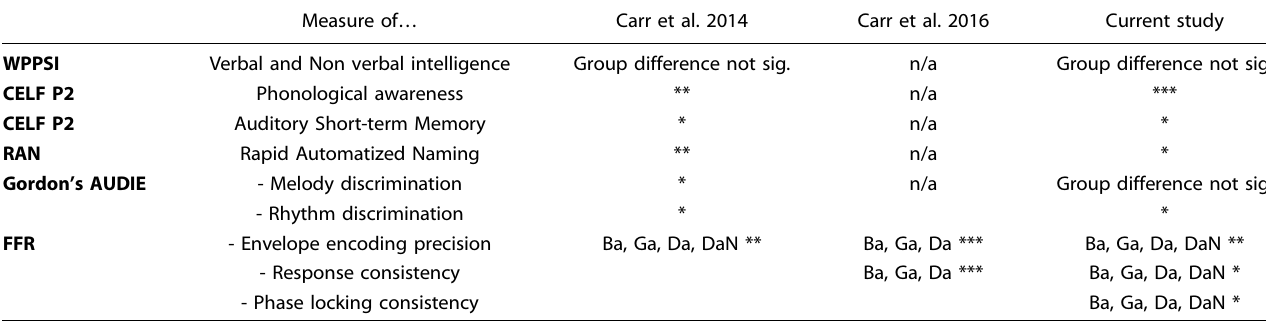
Table 2. Summary table of test and